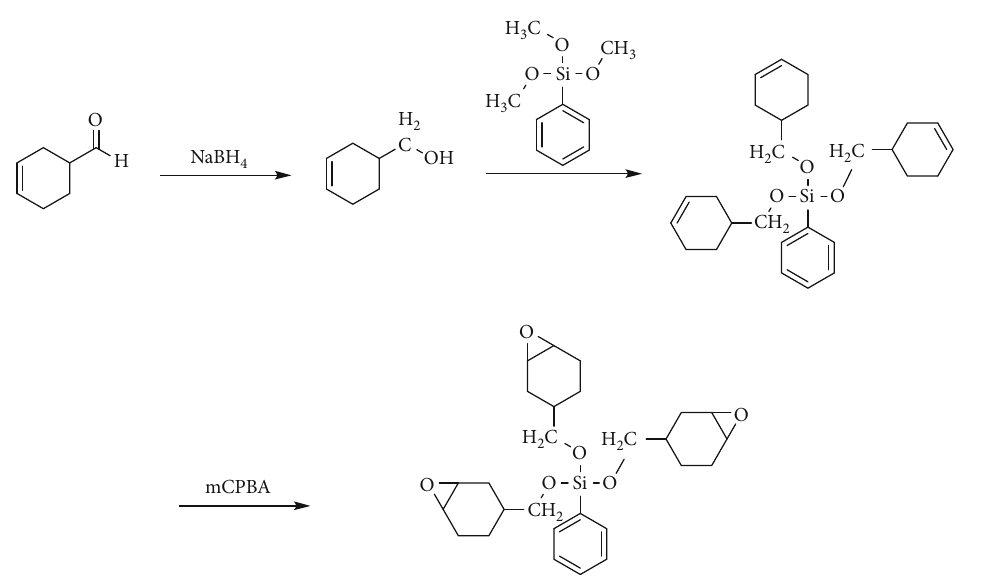
Scheme 2: Synthetic route of